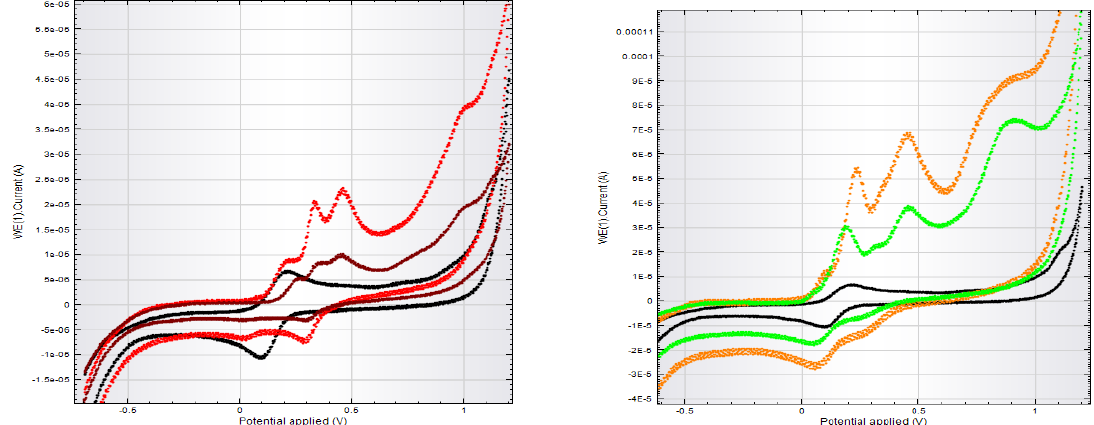
Figure A3. Left —Comparison between CVs for 0.5 mM of: potassium ferricyanide (black); 8a (red) and 8b (brown). Right —Comparison between CVs for 0.5 mM of potassium ferricyanide (black); and mixtures of 0.5 mM of potassium ferricyanide and: 0.5 mM of 8a (light green) and 8b (orange). Table A1. Comparative presentation of the scavenging effect of the synthesized compounds on ferricyanide. Compound E ox